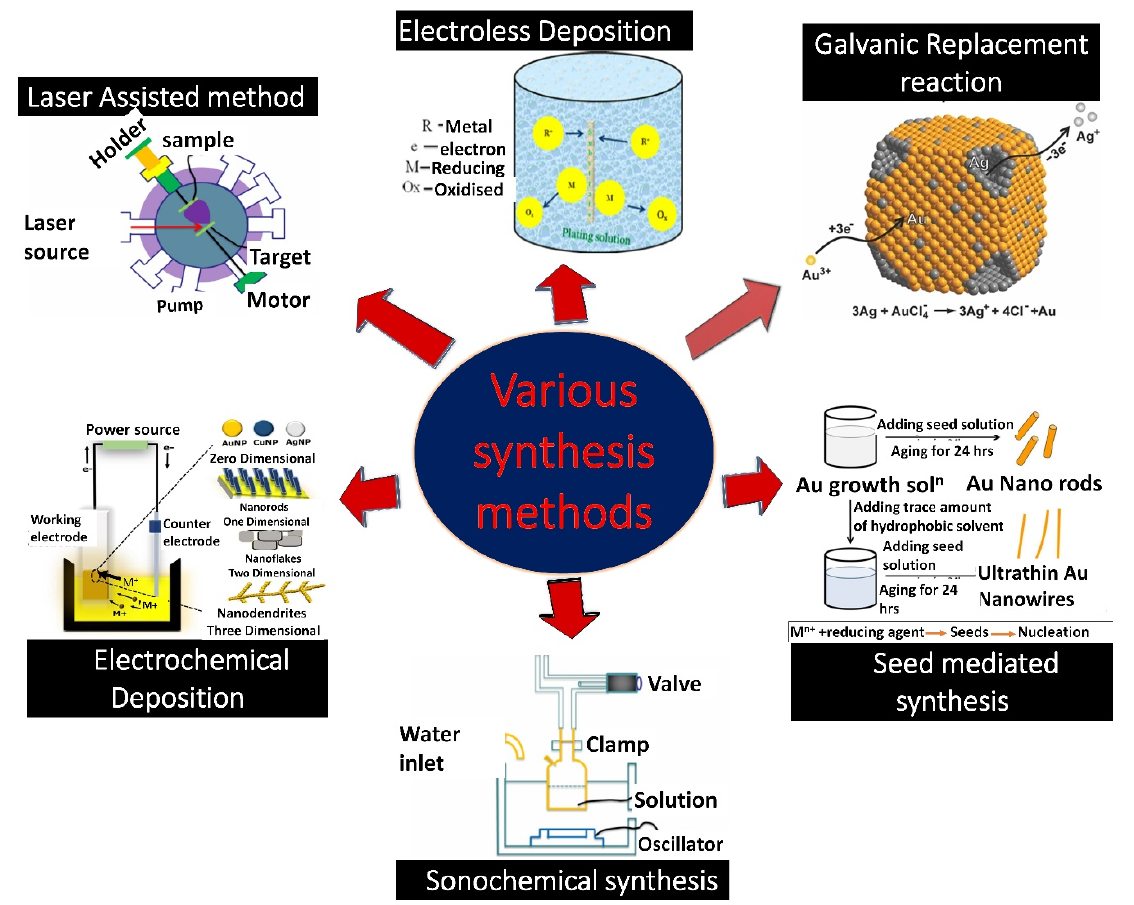
Figure 1. Schematic depicting the various methods of nanoparticles synthesis. Reprinted with permission from [31–34]. Copyright 2022, Tiwari et al.; Copyright 2020, Purohit et al., Copyright 2013, Xia et al., Copyright 2015, Li et al.